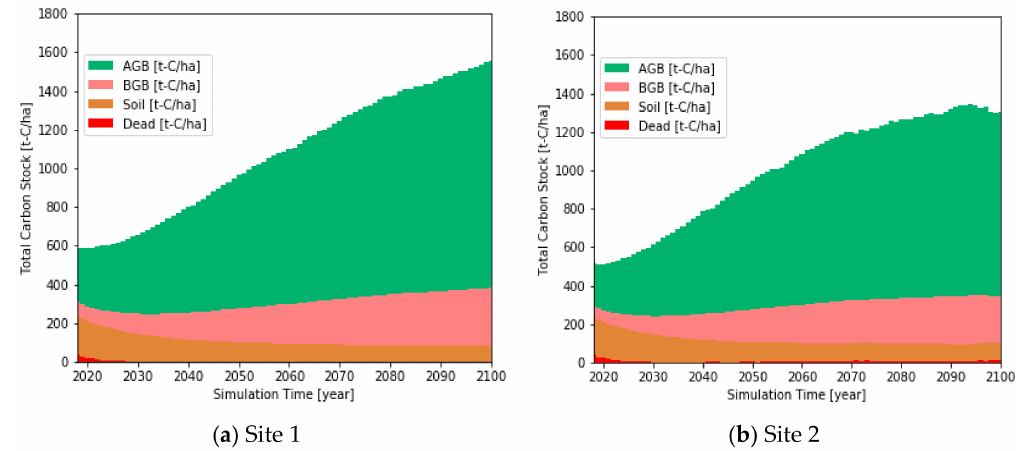
Figure 15. Carbon stock change by four components; Aboveground Biomass (AGB), Belowground Biomass (BGB), Dead wood biomass (Dead), and